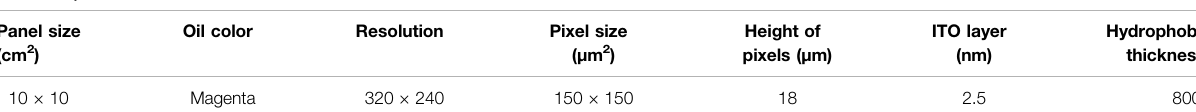
TABLE 2 | Parameters of the EWD.